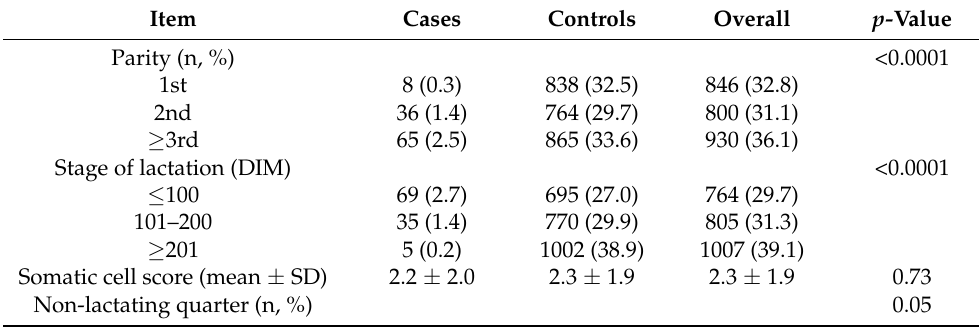
Table 1. Baseline characteristics of dairy cows with (cases, n = 109) and without (controls, n = 2467) repeated forced take-off. p -values derived from univariable logistic regression analyses testing the association between the respective baseline characteristic and the presence or absence of repeated forced take-off. Note percentage may not add up to 100 due to rounding